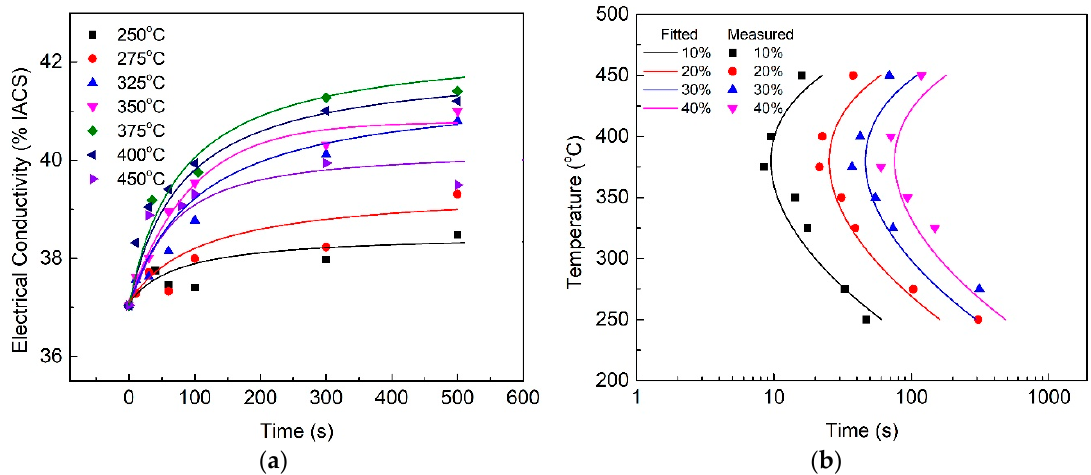
Figure 1. Effect of isothermal treatment on electrical conductivity (EC) of quenched HPVD casting samples ( a ); time–temperature–transformation (TTT) diagram of HPVD casting ( b ). The lines in ( b ) are the fits to the experimental data by using Equation (1).